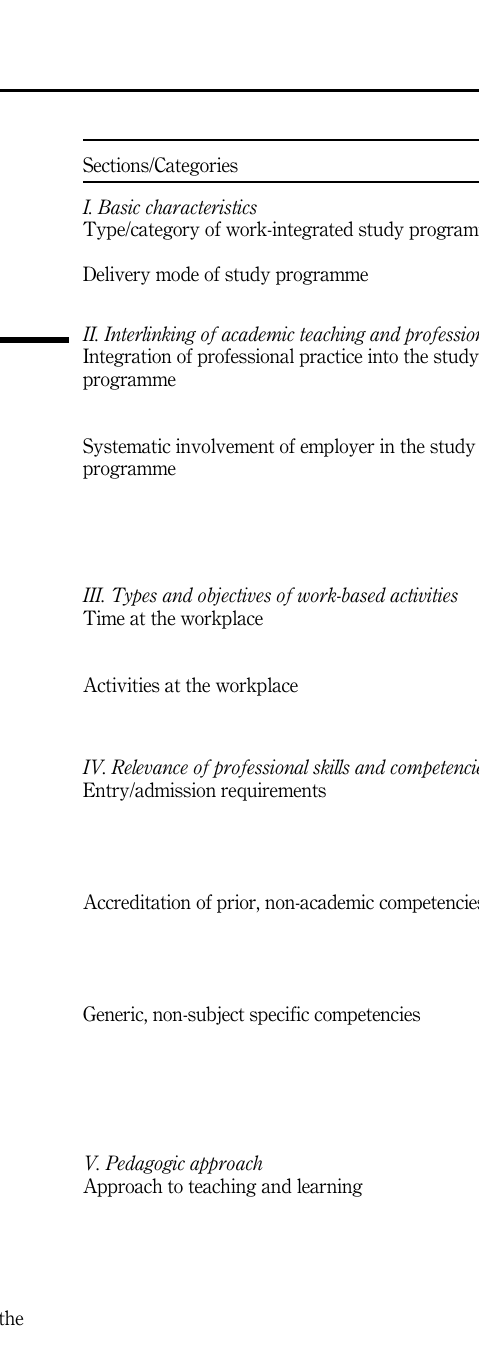
Table 2. Illustration of the ZELPH